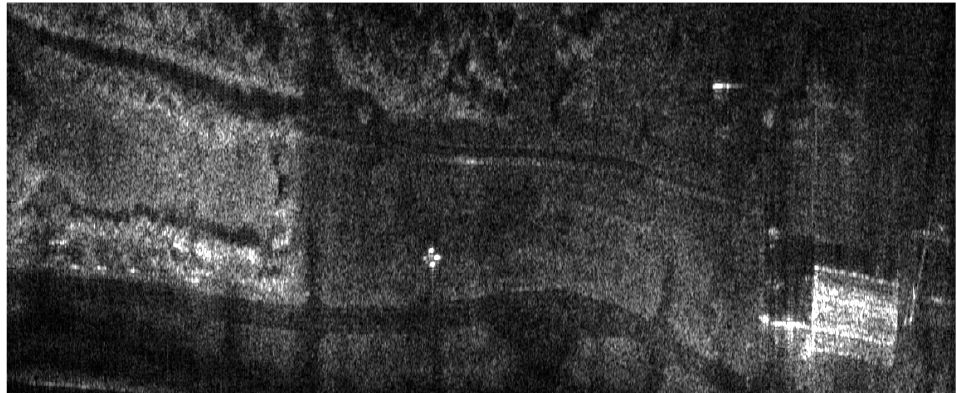
Figure 8. Radar terrain image obtained without navigation correction.